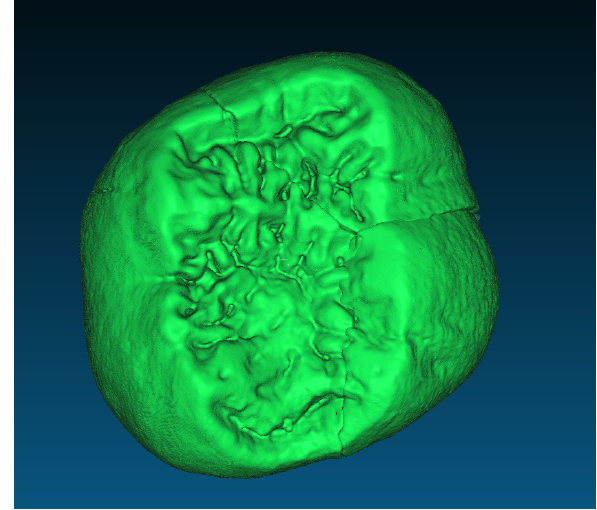
Figure 9. The results of applying Algorithm 2 to found tooth